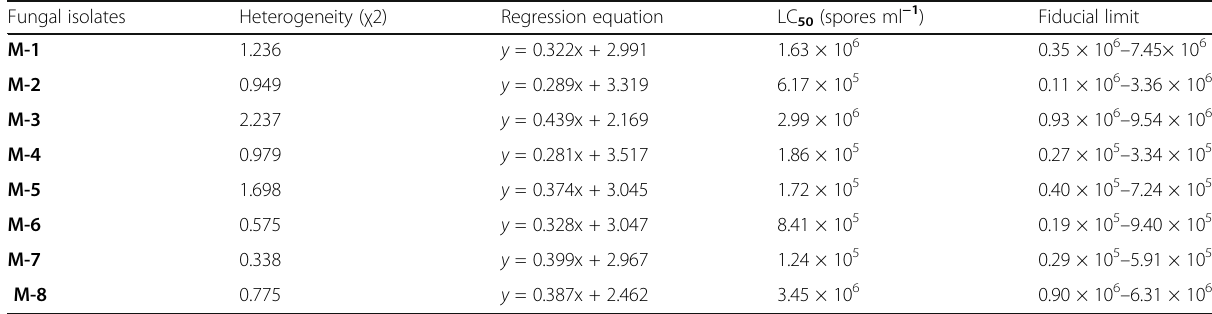
Table 2 Spore concentration mortality response of S. litura to different fungal isolates of M. anisopliae Fungal